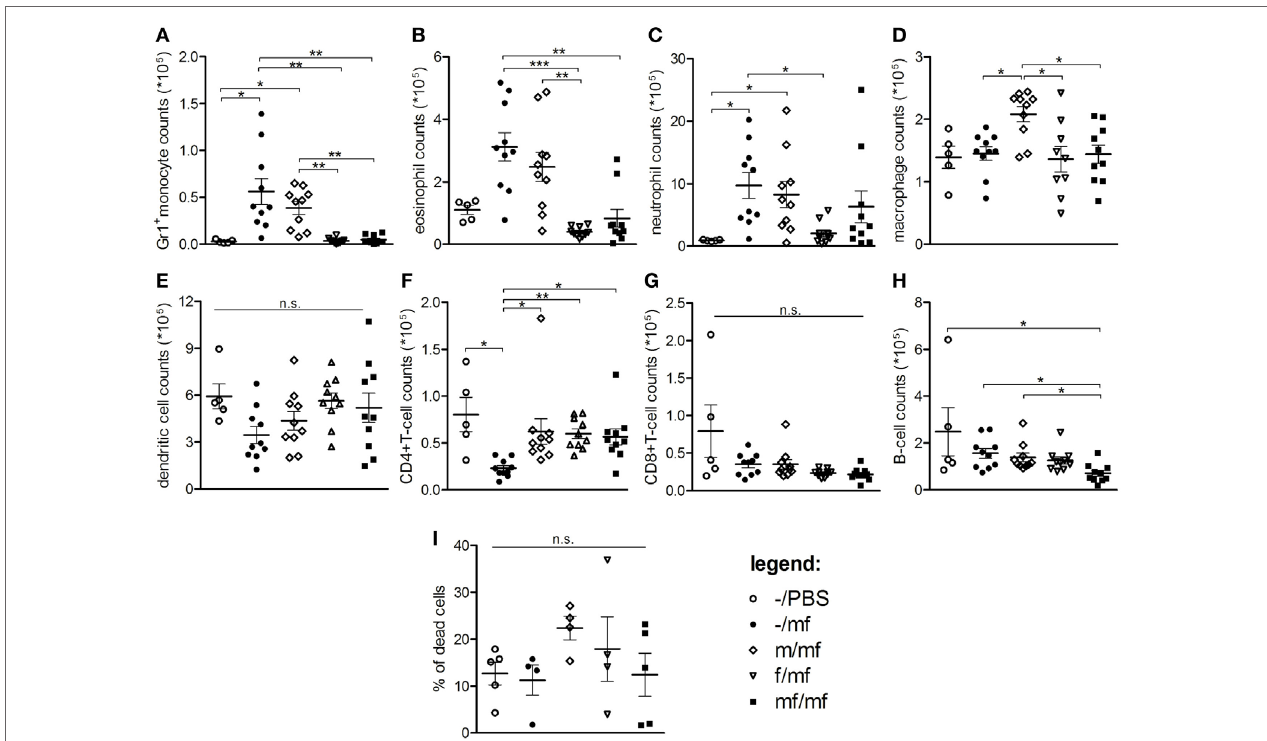
FigUre 1 | Flow cytometry: Female schistosomes suppress the recruitment of innate immune cells. Total numbers of (a) Gr1 + inflammatory monocytes, (B) eosinophils, (c) neutrophils, (D) macrophages/resident monocytes, (e) dendritic cells, (F) CD4 + -T cells, (g) CD8 + -T cells, (h) B cells, and (i) percentage of dead cells were analyzed in air pouch exudates. Data from individual experiments are depicted as individual symbols, lines represent mean ± SEM; n = 5 or 10 mice each group; * p < 0.05, ** p < 0.01, *** p < 0.001, n.s., not